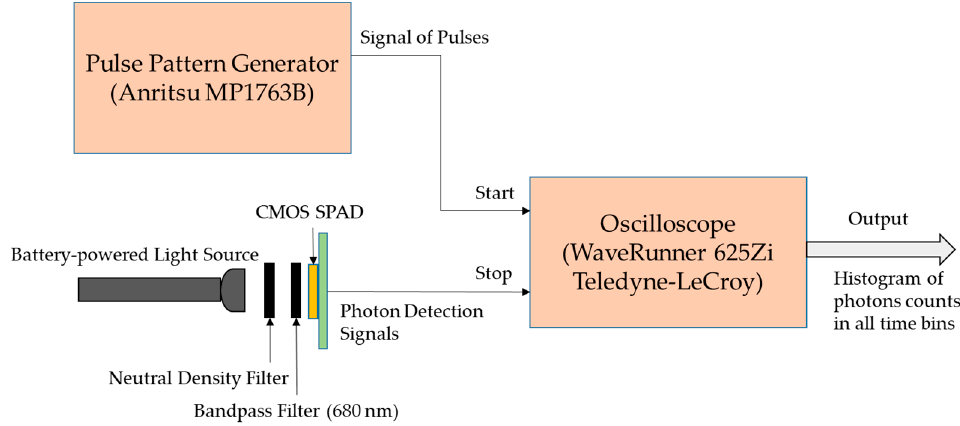
Figure 4. DNL measurement setup to acquire histograms of the PTA for all detected photons.